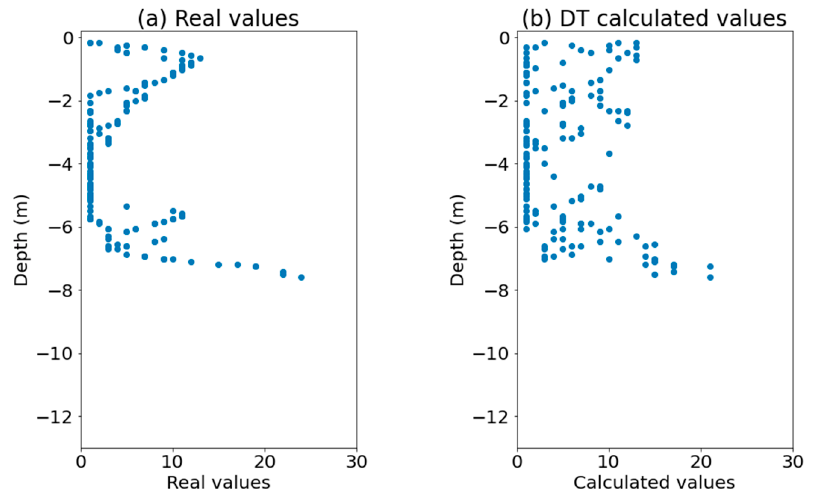
Figure 13. Real and calculated values for site 3. ( a ) Real values. ( b ) Values calculated by DT. ( c ) Values calculated using RF.